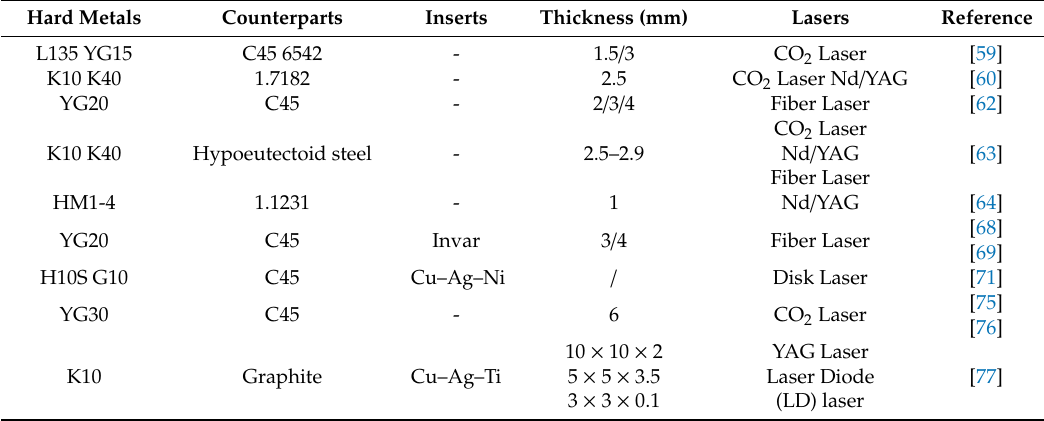
Table 3. Comparison of previously reported laser welding methods of dissimilar hard metal / steel joints. Nd / YAG, neodymium / yttrium aluminum